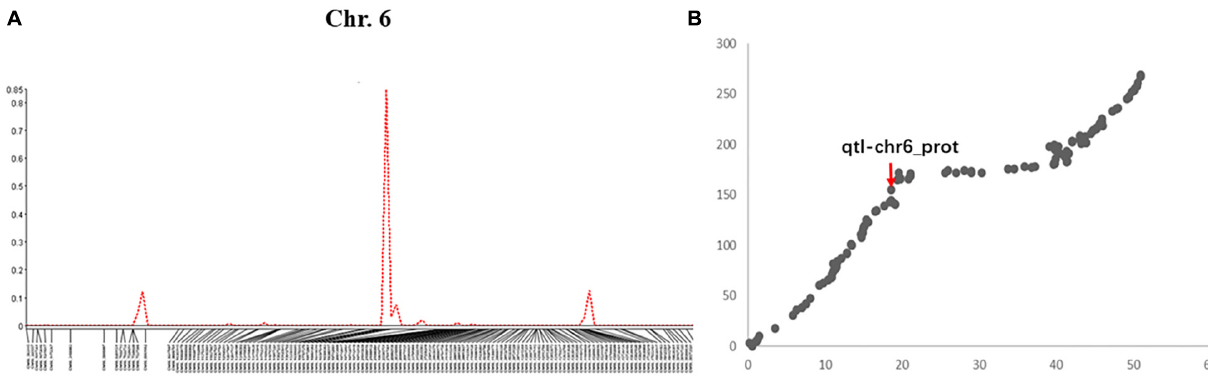
FIGURE 1 | (A) QTL mapping of seed protein content in soybean chromosome 6 based on single-trait multiple IM (SMIM) in Qgene, (B) The QTL, qtl-chr6_prot was mapped on the combined map between physical distance and genetic position of the chromosome 6, where the x-axis shows physical distance (Mbp) and the y-axis shows the genetic position (cM).